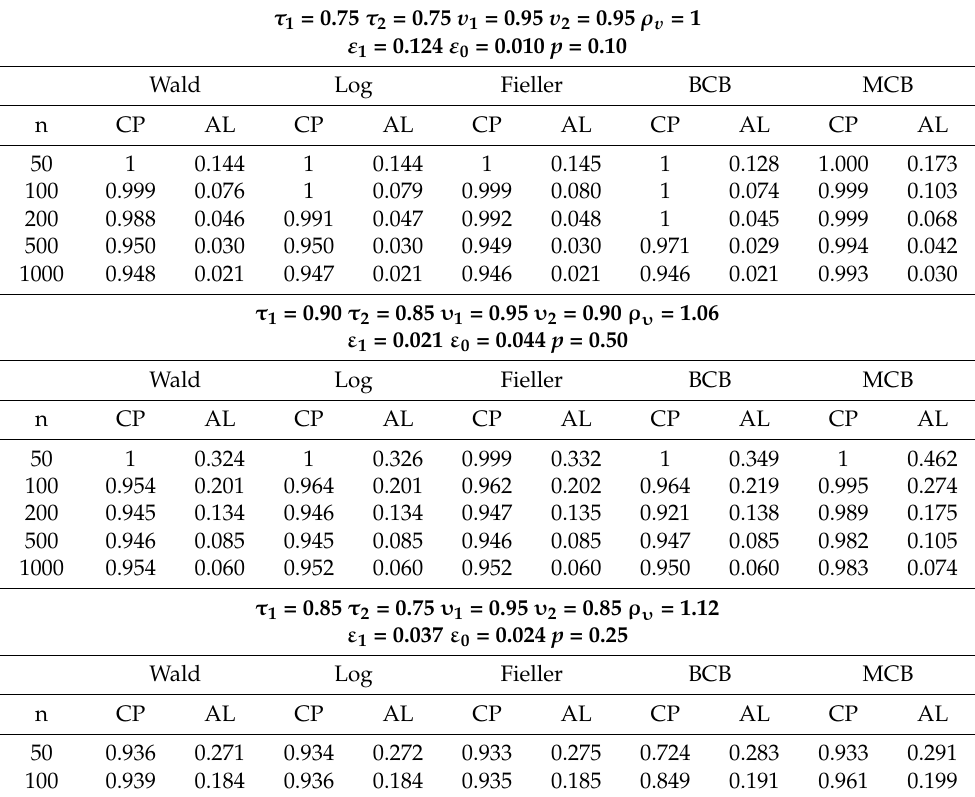
Table 5. Asymptotic behaviors of the CIs for the ratio of the two negative predictive